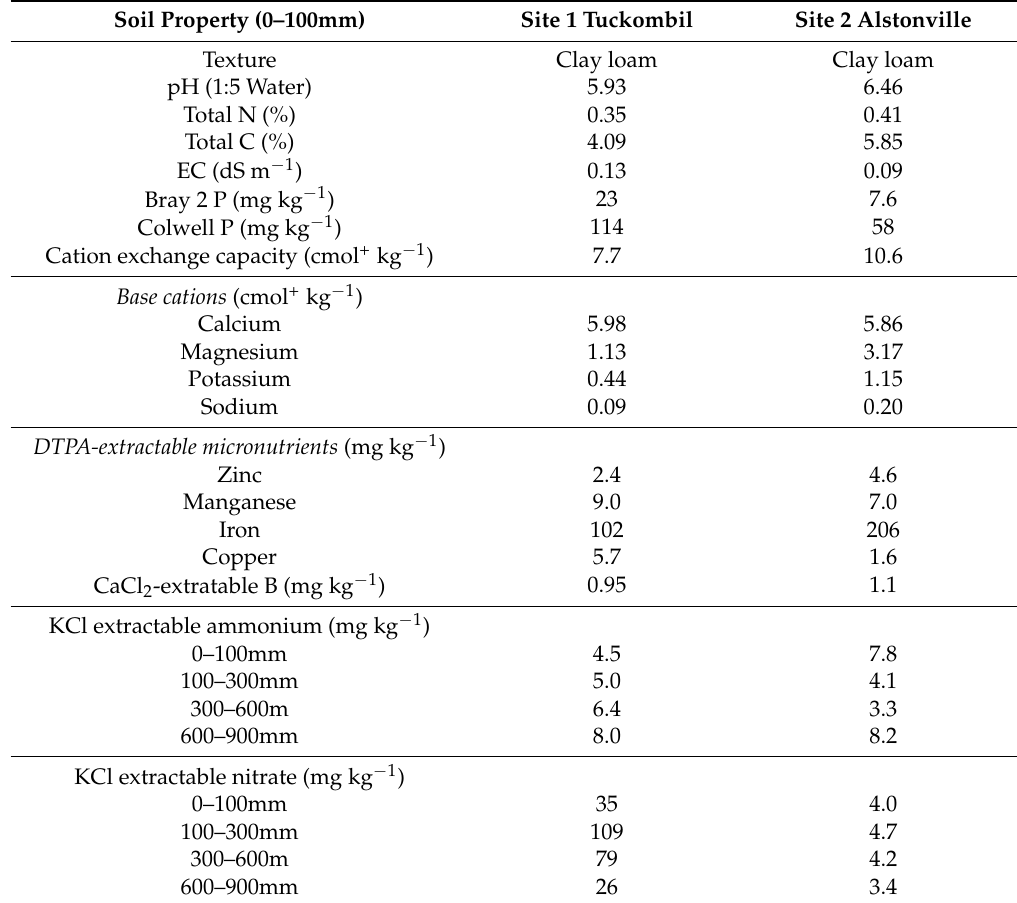
Table 1. Selected chemical properties of topsoils (0–10 cm depth) and mineral N to 90 cm depth at both